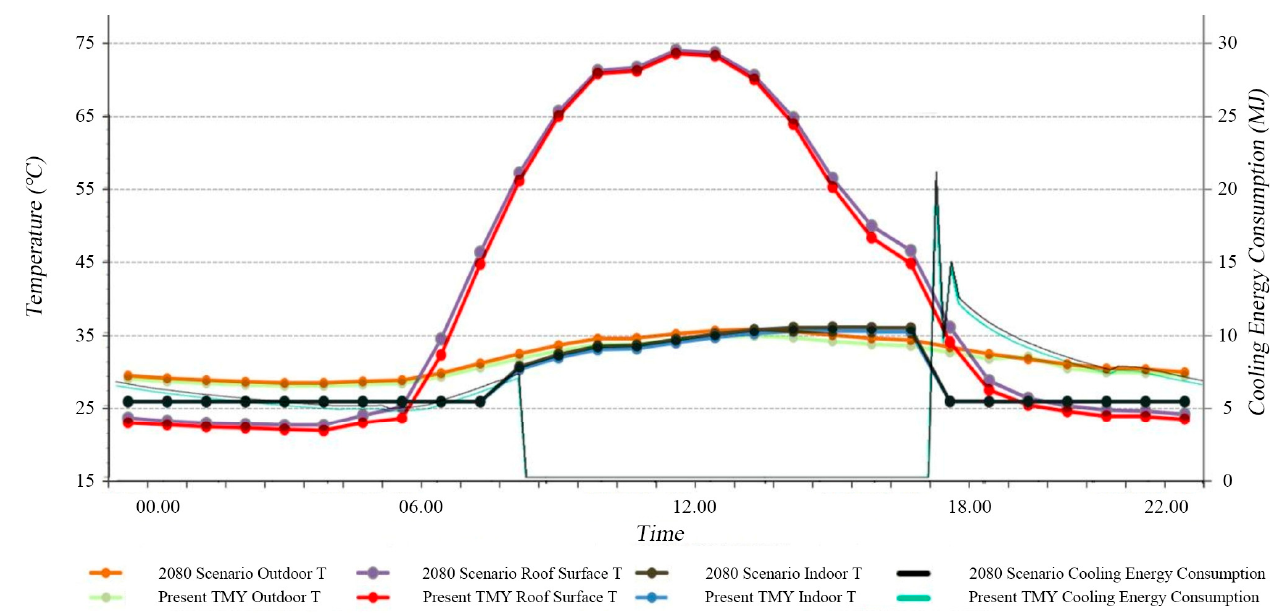
Figure 12. Thermal–physical behaviors of container housing prototype for present TMY and predicted 2080 scenario.